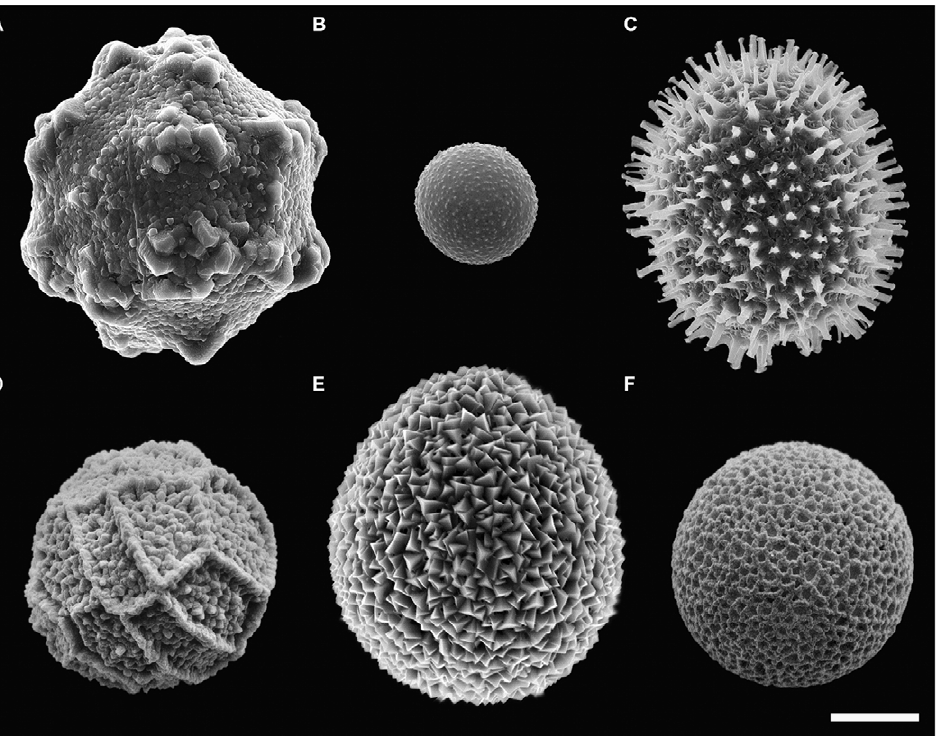
Figure 1. Morphological diversity of calcareous coccoid cells. (SEM). A: Scrippsiella bicarinata (GeoB 411, note the bicarinate tabulation resulting from the fusion of pre- and postcingular plate equivalents). B: Thoracosphaera heimii (CCCM 670, note the small size). C: Scrippsiella trochoidea (GeoB*185, note the spiny surface). D: Calciodinellum operosum (SZN # 74, note the holotabulate tabulation). E: Scrippsiella aff. trochoidea (GeoB 283, note the spiny surface). F: Calciodinellum aff. operosum (GeoB 34, note the smooth surface). Scale bar: 10 m